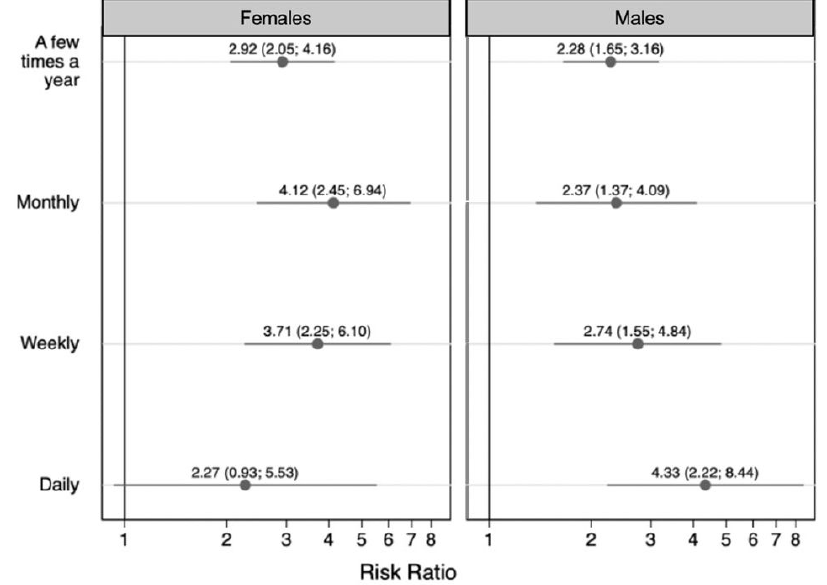
Figure 5. The sex-stratified association between having ever resided with someone with a substance use disorder and frequency of children’s depression (females n = 3201; males n = 3441). Symbols indicate relative risk ratios and lines indicate 95% confidence intervals. The referent group is children who never experienced